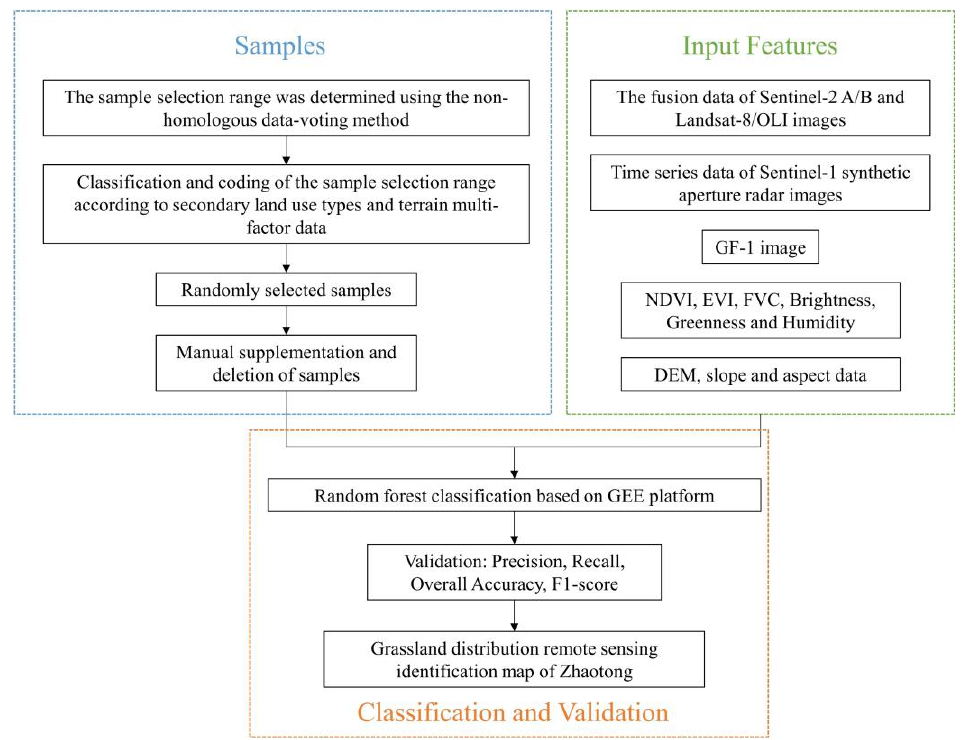
Figure 2. Experimental design of grassland remote sensing identification at a regional scale.